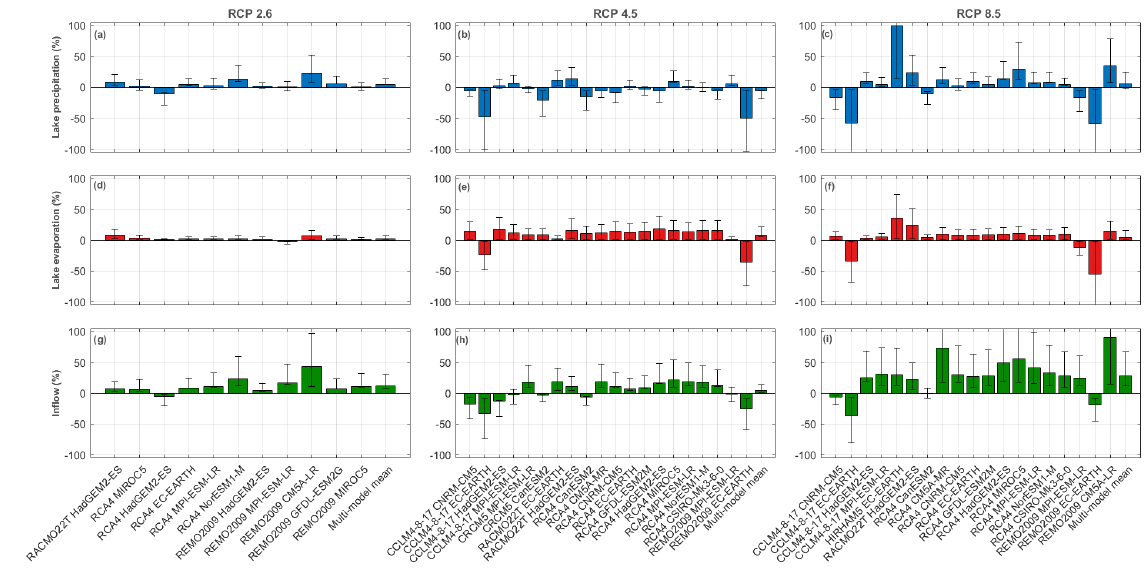
Figure E1. Bar plots showing the relative projected climate chance following RCPs 2.6, 4.5 and 8.5 for lake precipitation (a–c) , lake evaporation (d–f) and inflow (g–i) for the CORDEX simulations without bias correction. The climate change signal is defined as the difference between the future (2071–2100) and the historical (1971–2000) simulations. The whiskers indicate the 95% confidence interval of the change based on the 30-year annual